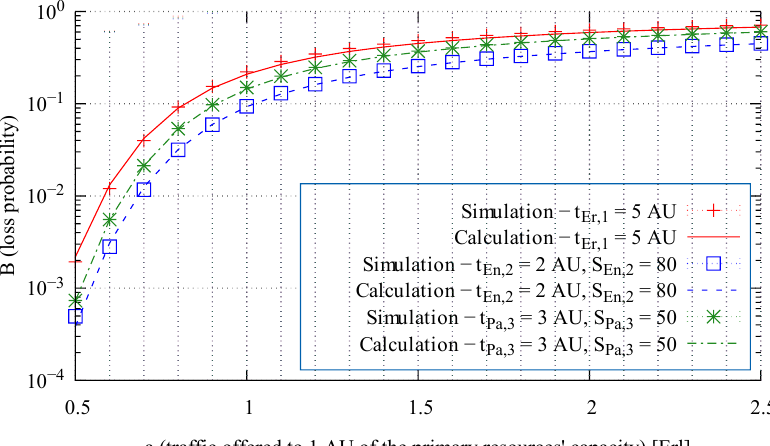
Figure 17. Loss probability (call congestion) of three selected traffic classes in the primary resources of System